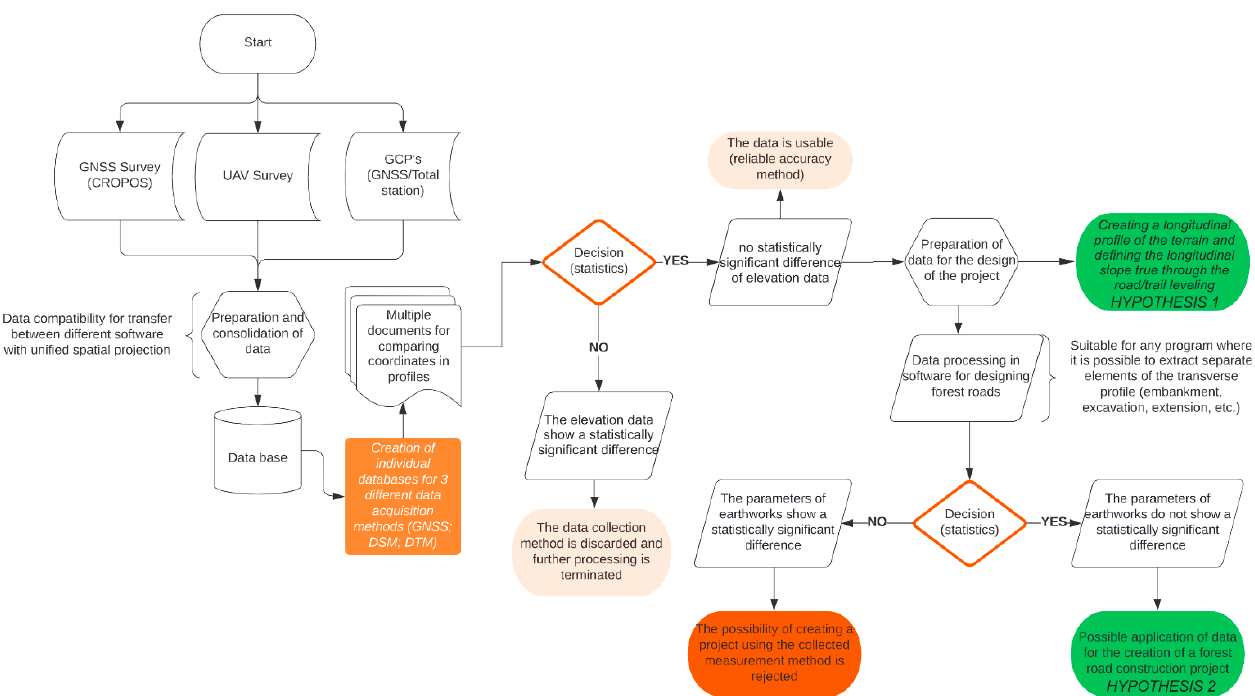
Figure 2. Data flowchart from stages of surveying field data to the final proof/refutation of hy- potheses.